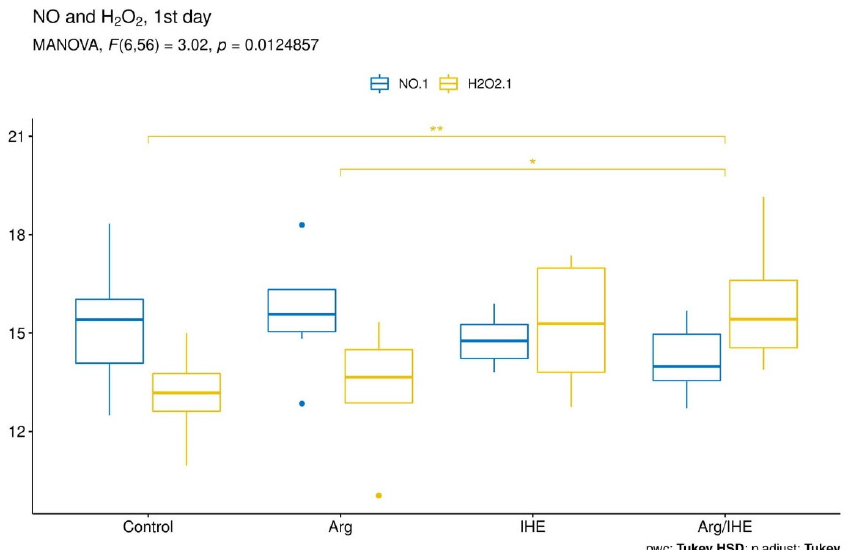
Figure 2. Visualisation of the MANOVA statistical analysis of changes in nitric oxide (NO) and hydrogen peroxide (H 2 O 2 ) levels on the 1st day of the training camp for the following groups: control, arginine (Arg), hypoxic exposure (IHE) and arginine with hypoxic exposure (Arg / IHE). Results of the Tukey HSD post-hoc comparisons are coded as follows: * p < 0.05, ** p < 0.01. The homogeneity of covariances and multivariate normality assumptions are